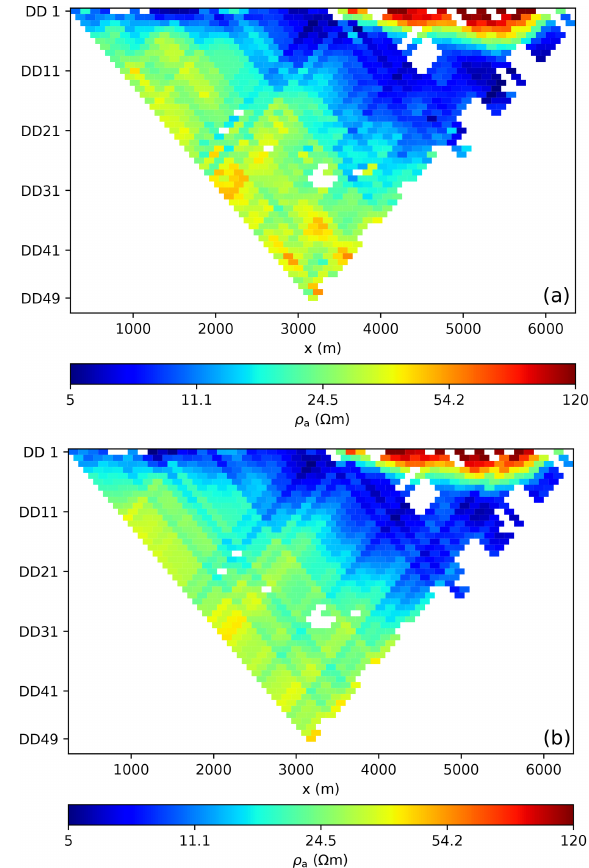
Figure 5. Unified dataset as apparent resistivity pseudo-section: measured data (a) and model forward response (b)